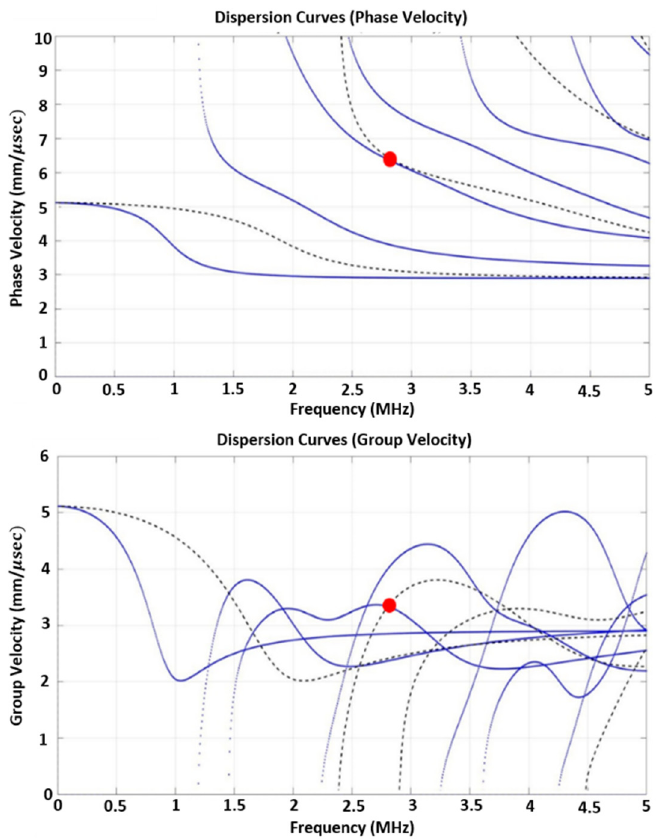
Figure 4. Numerical L mode dispersion curves of the specimen based on the SAFE technique.